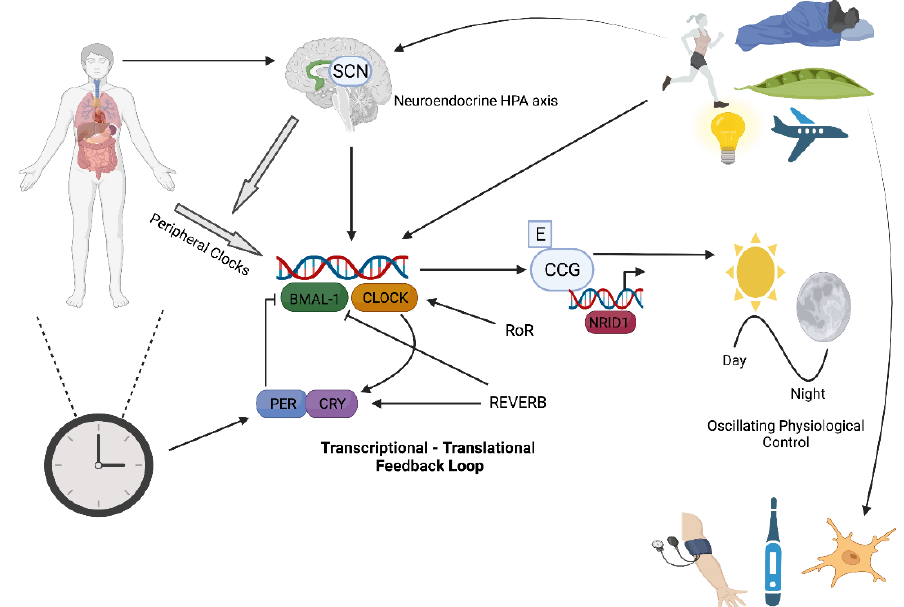
Figure 1. Circadian Rhythms in Humans. Crucial biological and physiological processes such as blood pressure control, antioxidant expression, body temperature, and immune function normally fluctuate in a circadian pattern (~24 h). These oscillations are coordinated by circadian clocks distributed in virtually every cell. The core molecular clock functions to direct a daily program of gene transcription and protein expression. The molecular clock involves a transcriptional–translational feedback loop (TTFL) of core clock genes (positive limb: BMAL-1 and CLOCK ; negative limb: PERs and CRYs ) that act to modulate the gene expression of clock-controlled genes (CCG) which generate tissue-specific circadian rhythms in transcription and cellular function across the day, even in the absence of external cues. The principal pacemaker of the circadian clock in humans is located within the suprachiasmatic nucleus (SCN) region of the hypothalamus. This master clock coordinates the activity of downstream peripheral tissue clocks in response to several stimuli such as the day-night cycle, food ingestion, exercise, and sleep. Figure key = SCN: suprachiasmatic nucleus; HPA: hypothalamic-pituitary-adrenal axis; CCG: clock-controlled genes; E: E-box motif .